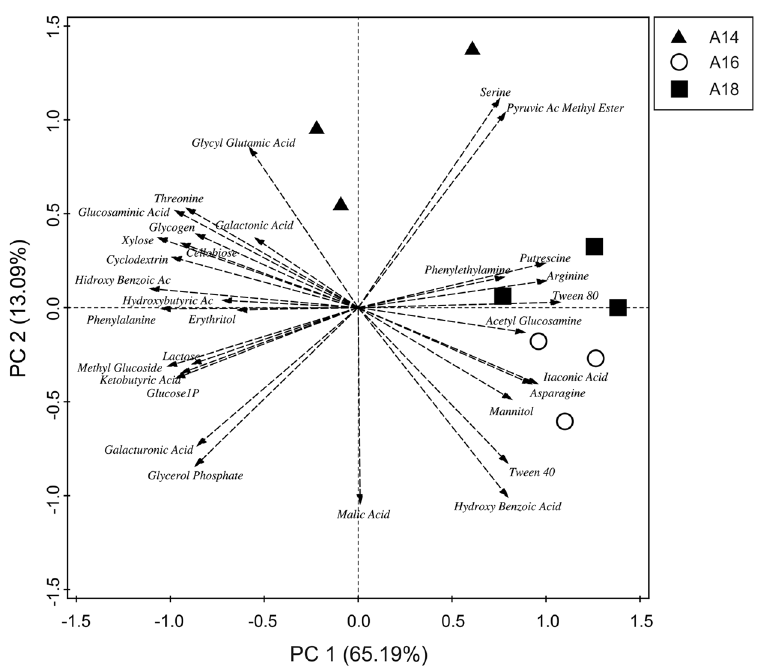
Figure 1. Principal component analysis (PCA) biplot of community level physiological profiles (CLPPs) found in soil samples of the studied layers A14 (upper), A16 (intermediate) and A18 (lower). Percent variability explained by each principal component is shown in parentheses after each axis